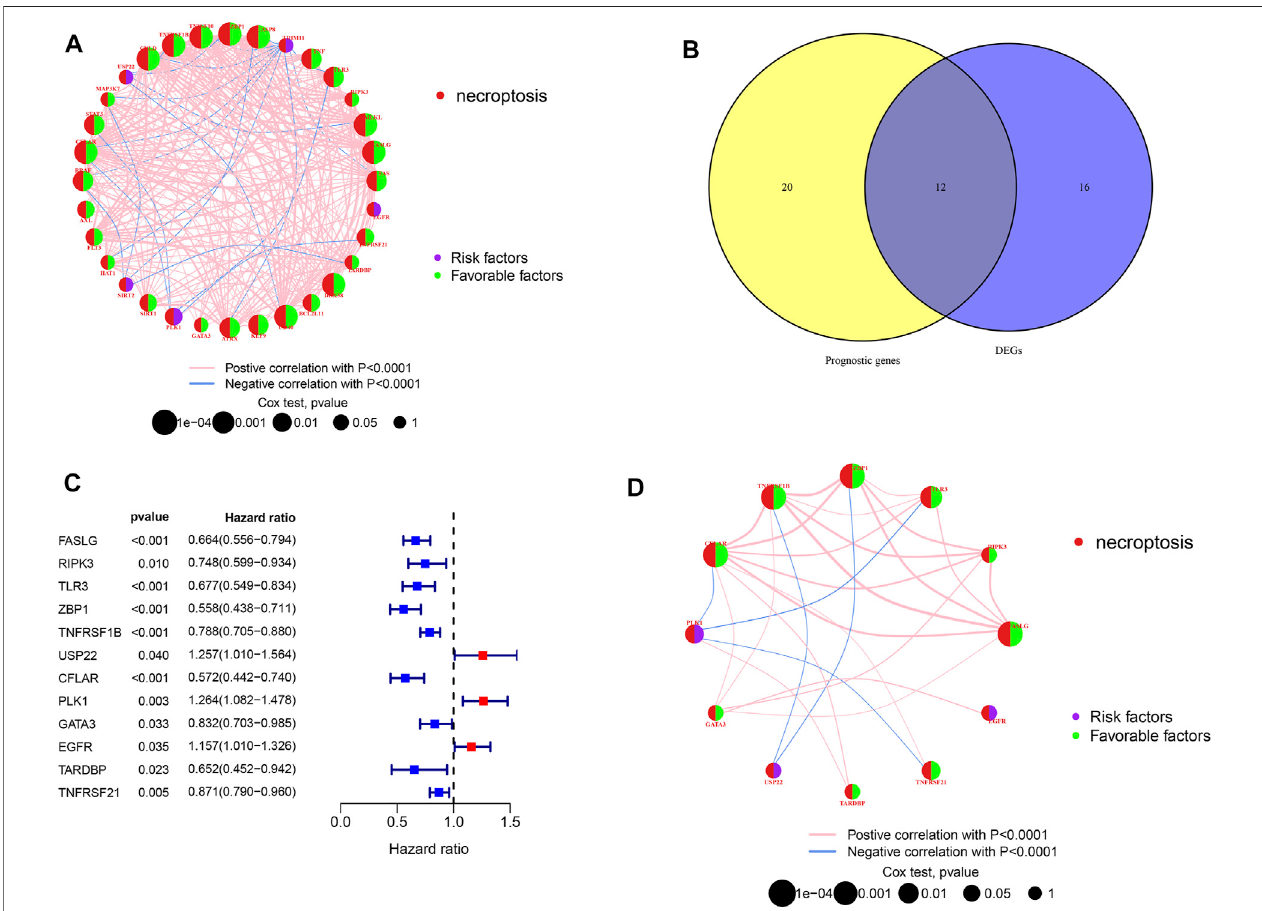
FIGURE 2 | Candidate prognostic DEGs identi fi cation in TCGA-SKCM. (A,D) Interactions between prognostic NRGs and prognostic DEGs in SKCM. The lines connecting the NRGs represent the correlations, and thicker lines represent larger correlations. Pink and blue represent positive and negative correlations. (B) Venn diagramofNRGs identi fi edbyunivariateCoxanalyses and differential expression. (C) Forestplotsofcorrelationsbetween12NRGs andOSofpatients inTCGA